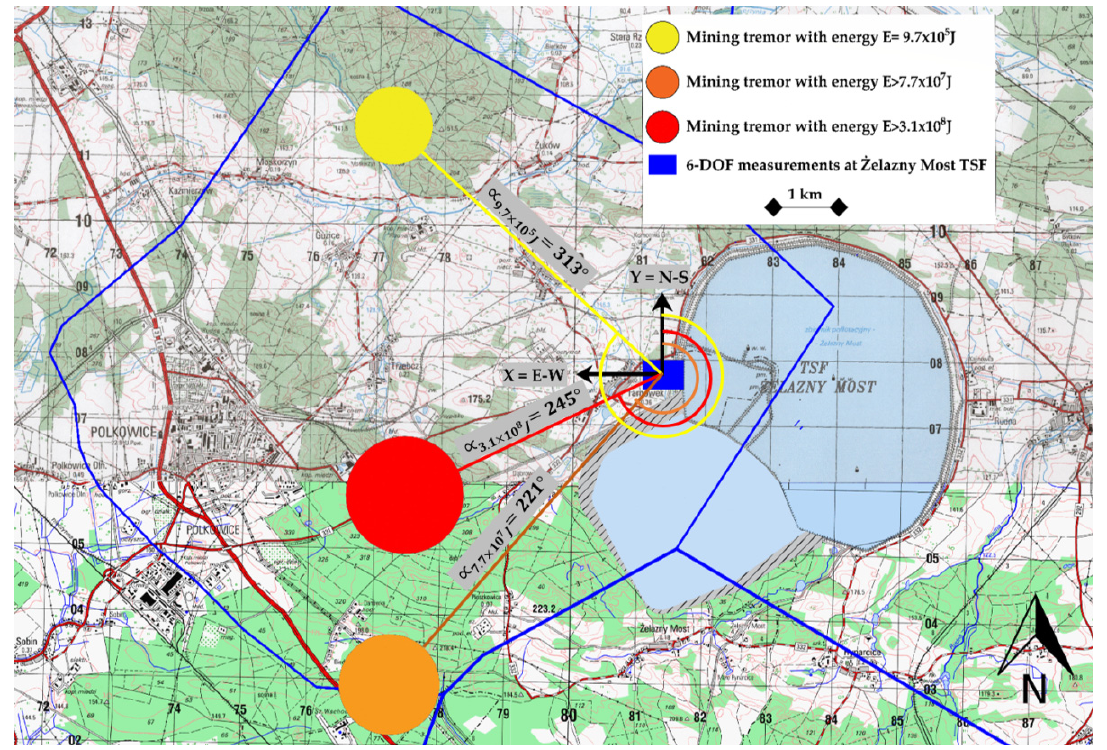
Figure 1. Location of the 6-DOF measuring station and epicenters of the analyzed mining tremors in the LSCB area.